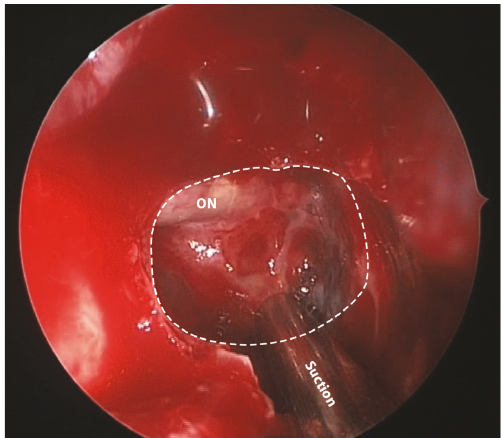
Figure 3: Top view of Onodi cell (white dashed line) showed dehiscence of the bone over the naked right optic